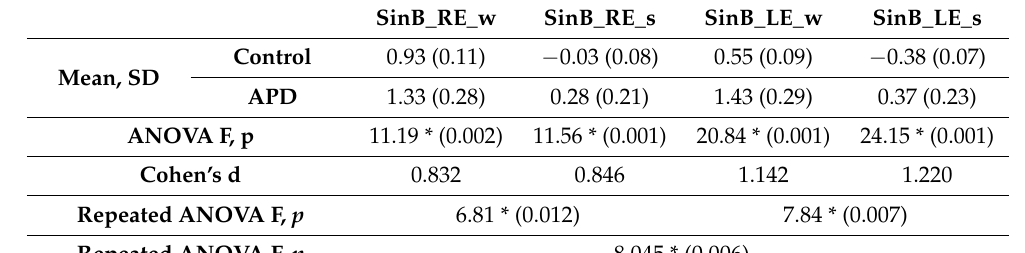
Table 1. Mean scores and standard deviations of SinB (Speech-in-Babble test) measures (word and syllable based, right and left ear) for control and APD (Auditory Processing Disorder) group, and ANOVA and Cohen’s d.